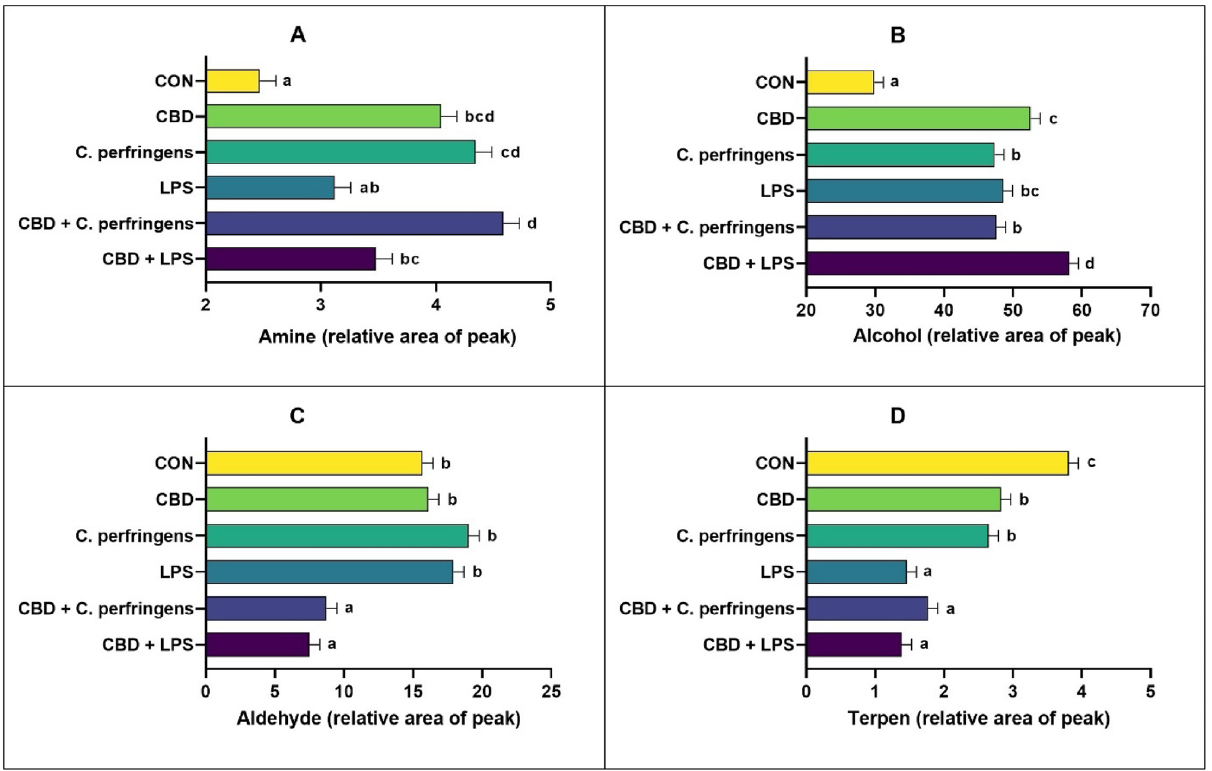
Figure 2. Main groups of chemical compounds detected in chicken breast meat. CON: received the basal diet over the entire period of the experiment and no challenge; CBD: received the CON diet supplemented (on top) with 30 g/kg Cannabis sativa extract; C. perfringens and LPS: received the CON diet and subjected to C. perfringens and E. coli LPS challenge, respectively; CBD + C. perfringens and CBD + LPS: received the CBD diet and subjected to C. perfringens and E. coli LPS challenge, respectively. (a–d) Different letters indicate significant differences (P < 0.001). The error bars indicate the standard error values for the 8 chickens in each treatment